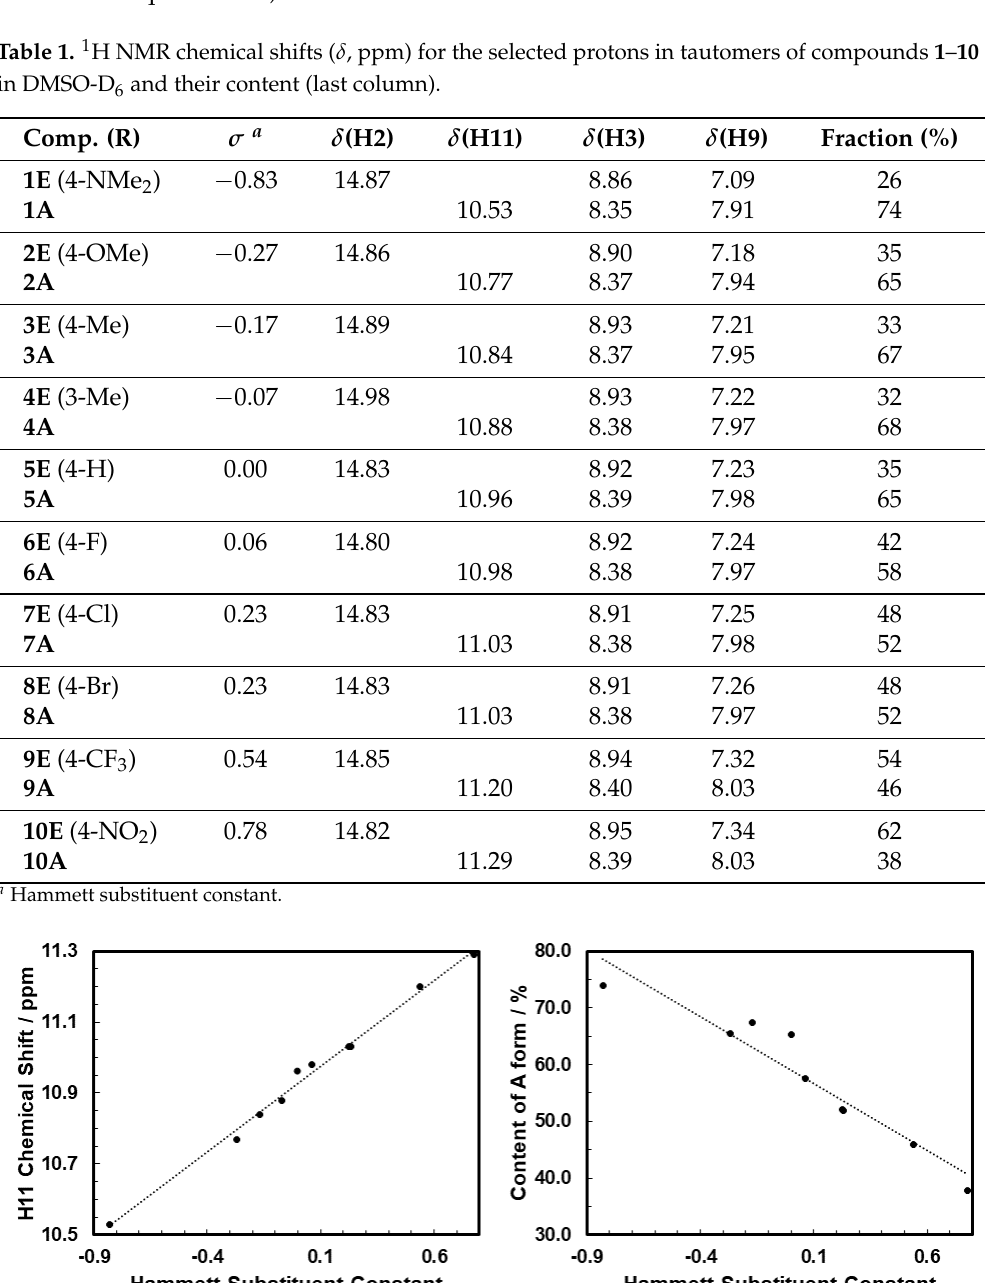
Table 1 lists the chemical shifts for hydrogen atoms H2, H11 (N—H), H3, and H9 (C—H) in the isoquinoline fragment for both A and E